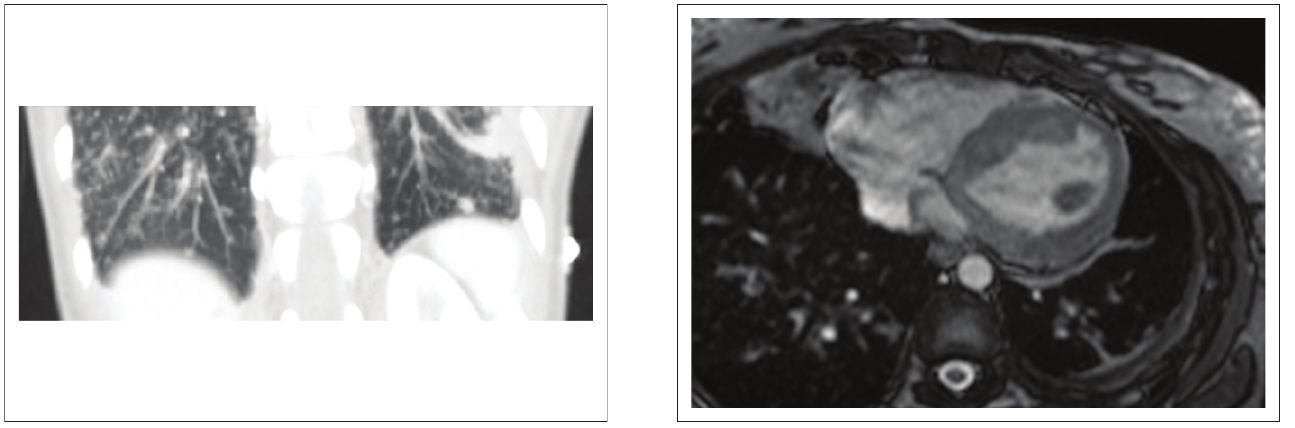
FIGURE 5: Coronal reformatted CT images of the lower lung fields. FIGURE 6: Axial dual chamber cardiac T2-weighted MRI image.